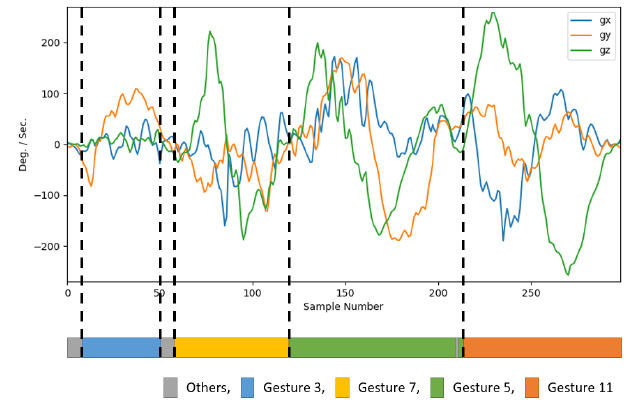
Figure 16. An example of test sequence produced by a gyroscope containing four gestures (Gesture 3, Gesture 7, Gesture 5, and Gesture 11). The bottom of the figure reveals the gesture-spotting results by